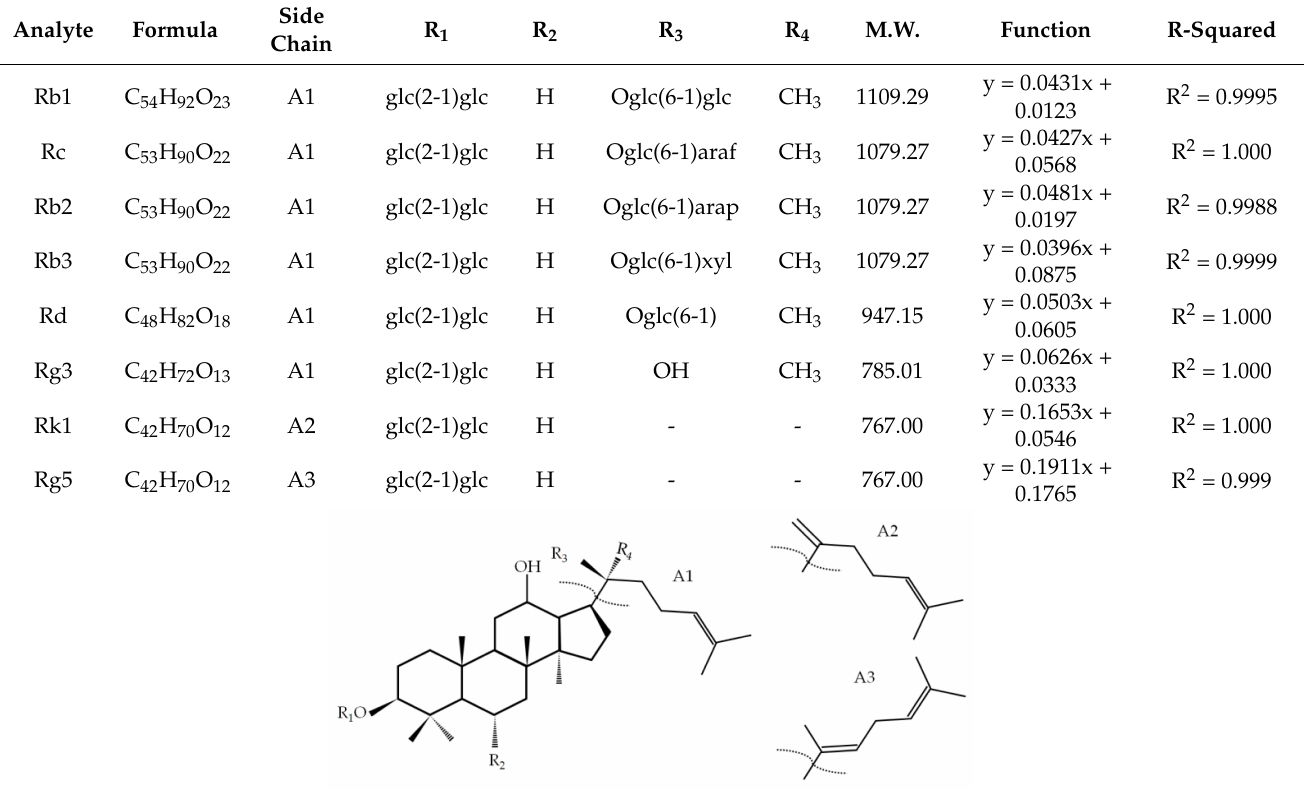
Table 2. Chemical structures and molecular of reference ginsenoside standards in this study. M.W., molecular weight.; glc, β - D -glucopyranosyl; arap, α - L -arabinopyranosyl; xyl, β - D -xylopyranosyl; araf, α - L -arabinofuranosyl.